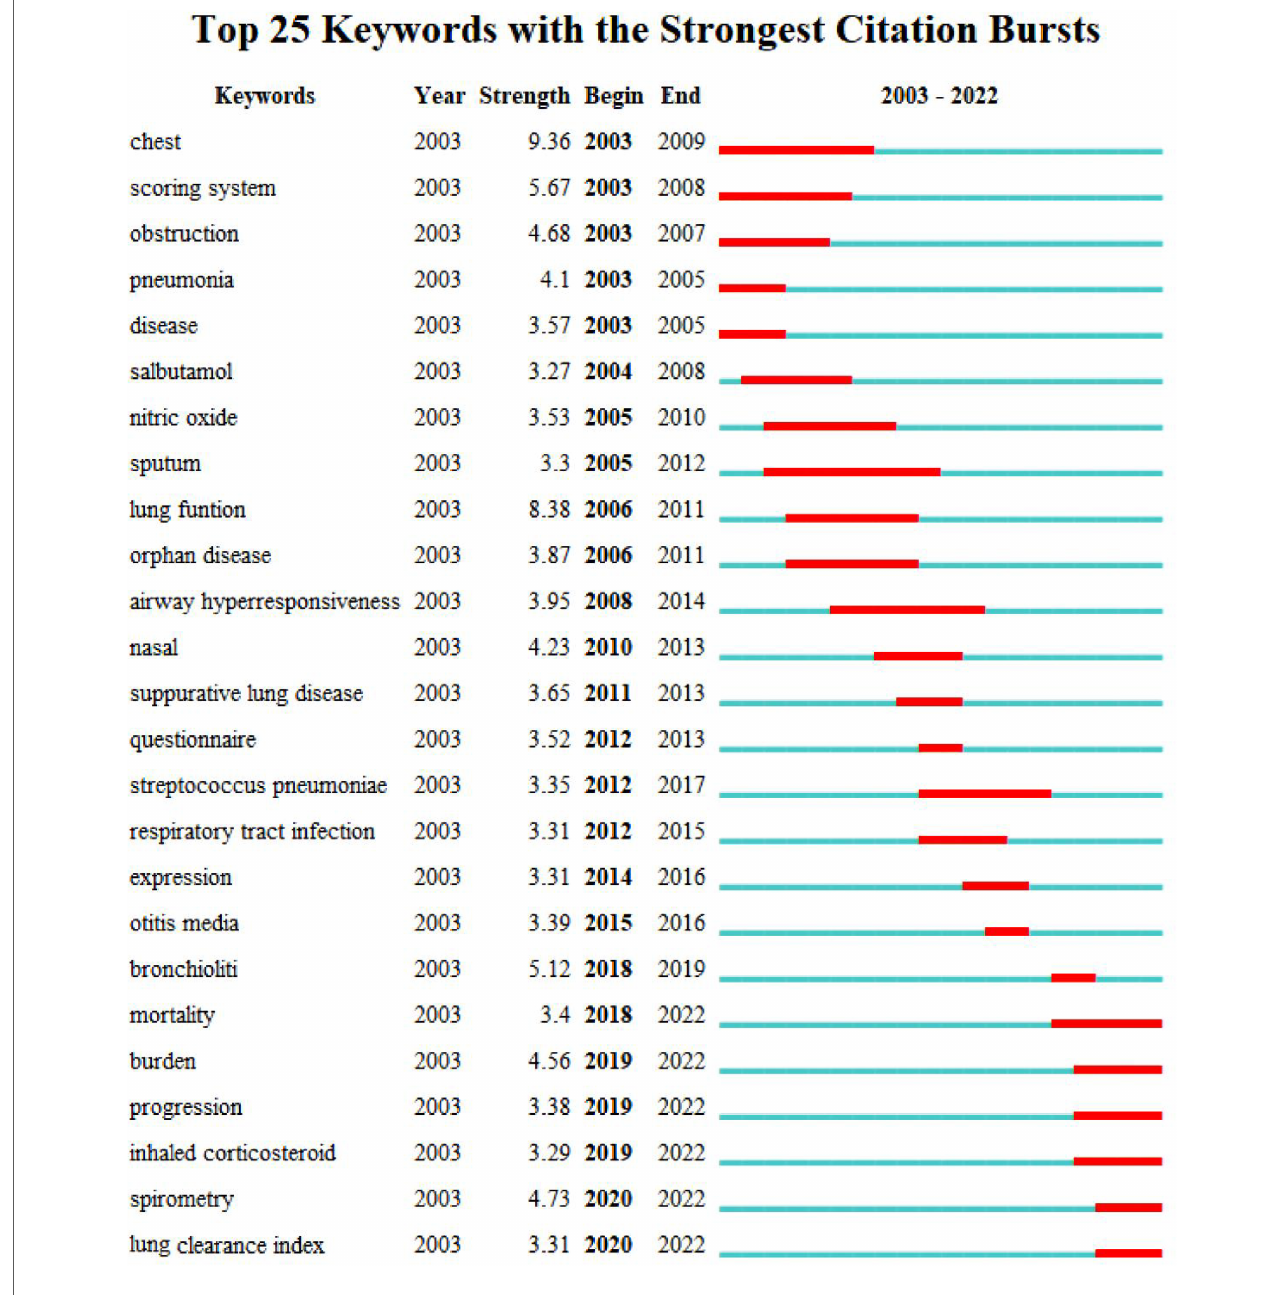
FIGURE 8 Top 25 keywords with the strongest citation